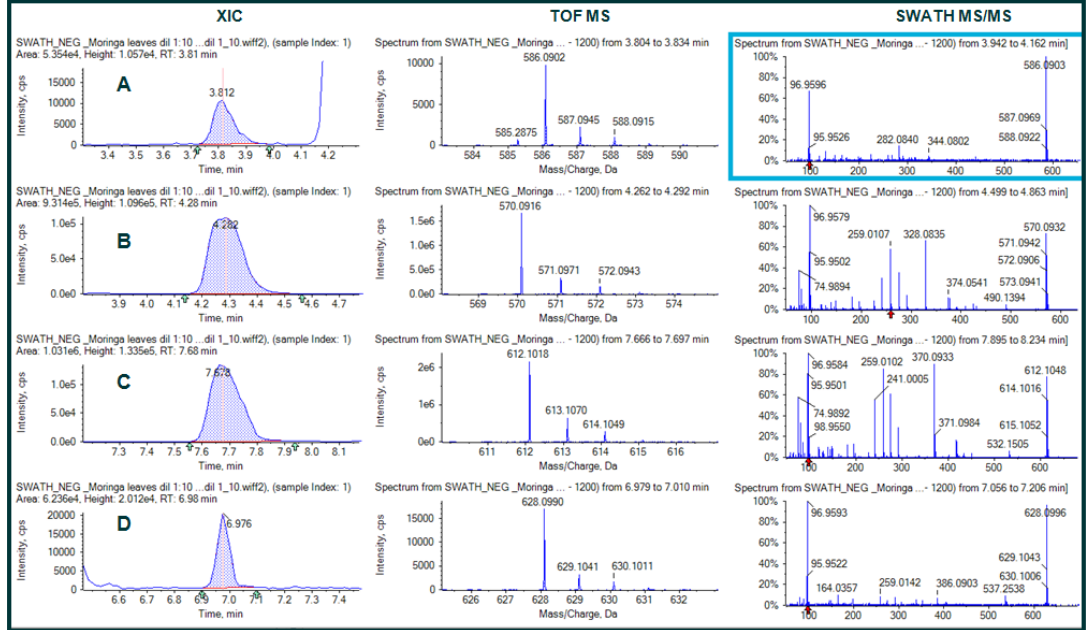
Figure 1. Extracted ion chromatograms XIC, MS and SWATH MS/MS spectrum of MOLE extract. ( A ) Glucosoonjnain (tR: 3.81), ( B ) Glucomoringin (tR: 4.28), ( C ) 4- O -acetylrhamnopyranosyloxybenzylGS (tR: 5.99, 6.4, 7.68) and ( D ) 4- O